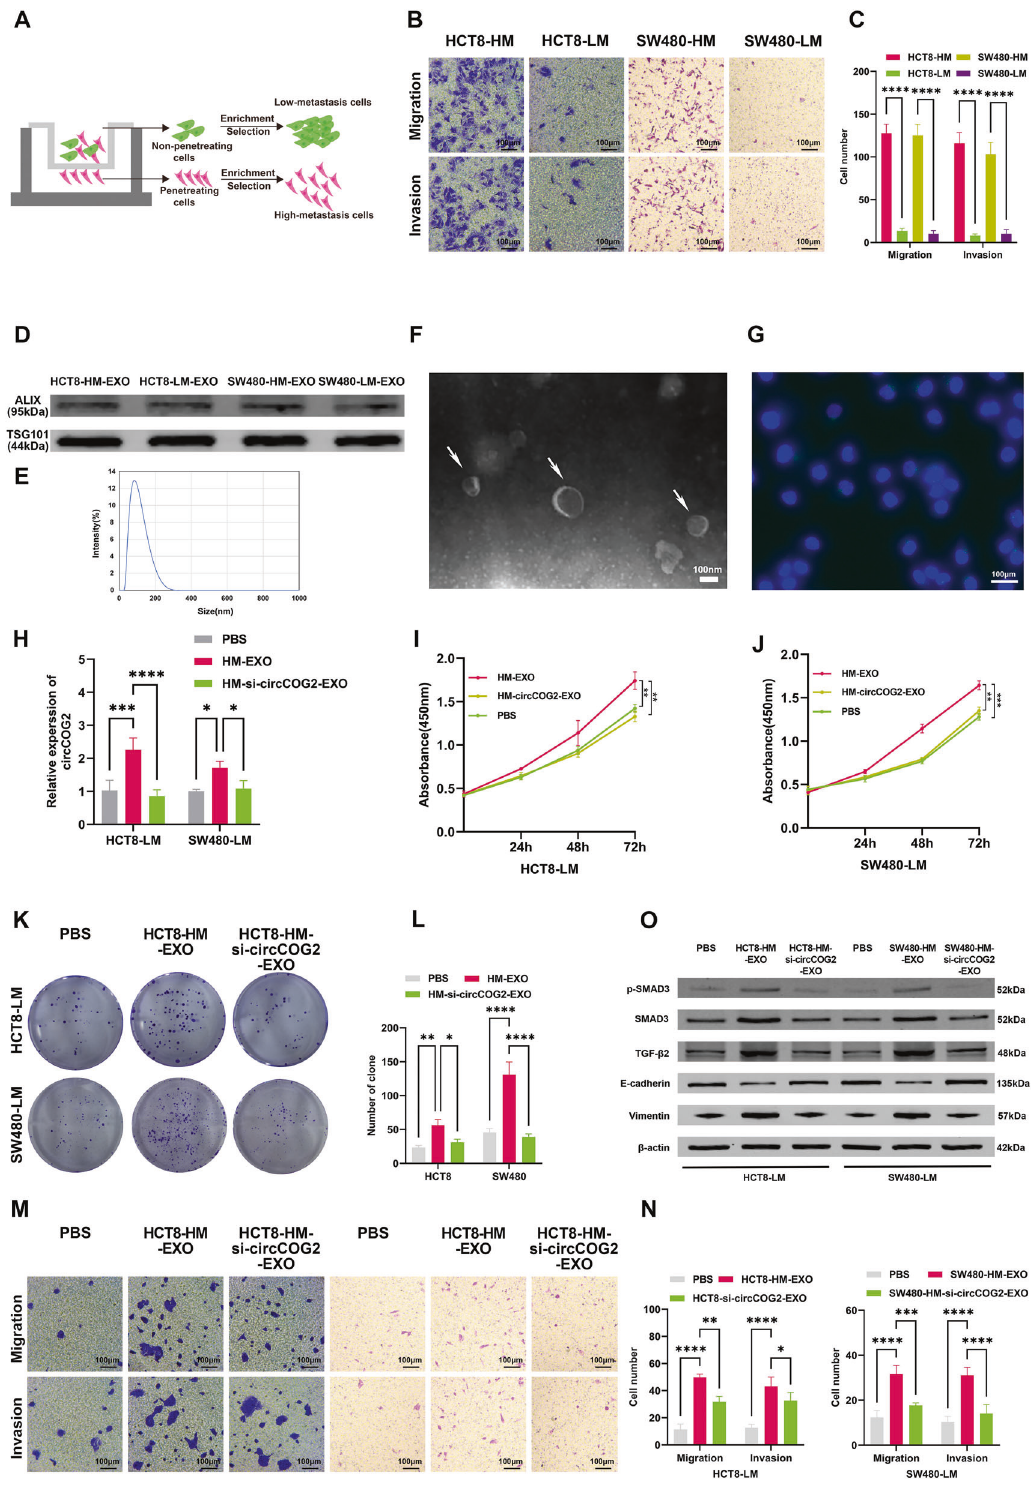
Fig. 6 Exo-transmitted circCOG2 promotes CRC progression in vitro. A The illustration of establishing CRC cell lines with high metastatic potential or low metastatic potential. B , C The metastatic potential of CRC cells with different metastatic potential was con fi rmed by transwell assay. D Western blot showed the marker of exosomes. E NTA showed the size of exosomes. F TEM showed the microstructure of exosomes (white arrows). G The exosomes were stained by PKH67 (green fl uorescence) were cocultured with CRC cells, and cell nuclear were stained by DAPI (blue fl uorescence). H The expression of circCOG2 in cell cocultured with PBS, HM-EXO or HM-si-circCOG2-EXO. I – L CCK-8 and colony formation assays indicated exo-transmitted circCOG2 promoted the proliferation of CRC cells with low metastatic potential. M , N Transwell assay indicated that exo-transmitted circCOG2 promoted migration and invasion of CRC cells with low metastatic potential. O Exosome- transmitted circCOG2 promoted EMT and TGF- β 2/SMAD3 pathway. * P < 0.05; ** P < 0.01; *** P < 0.001; **** P < 0.0001; P -values were calculated by Student ’ s